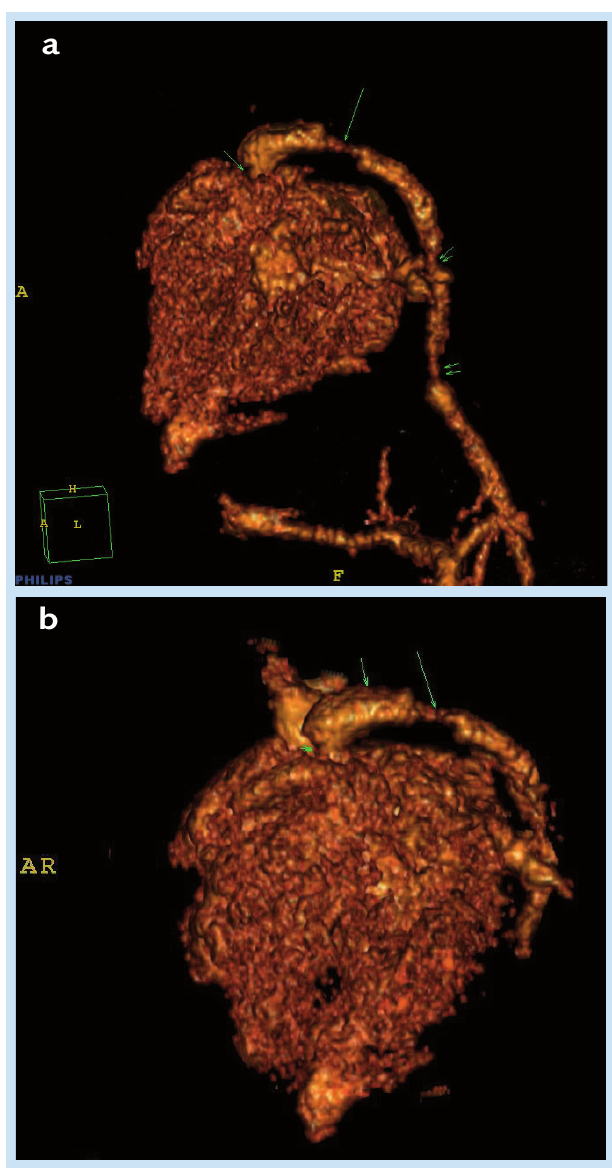
Fig. 1 (a) 3D CT aortogram AP view demonstrating supravalvular aortic stenosis at the level of the sinotubular junction (short arrow), coarctation of the aorta distal to the left subclavian (long arrow), coarctation distally of the descending abdominal aorta (double arrows). (b) Lateral 3D CT aortogram showing poststenotic dilatation of the aorta (short arrows) and coarctation of the aorta (long